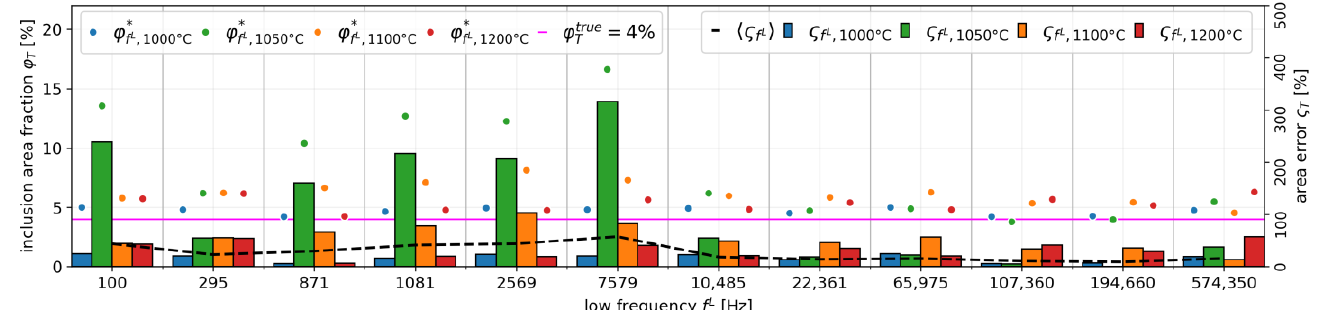
Figure 14. Image reconstruction accuracy result.